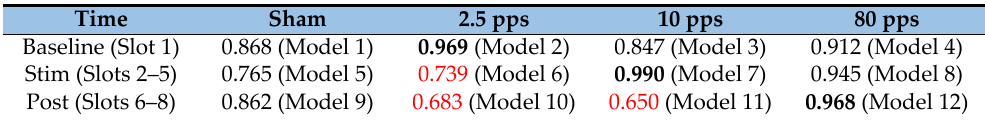
Table 9. Confusion matrix results ( kappa ) for the 12 models in Phase 4. Values in bold are in the upper quartile of all 16 values, and those in red in the lower